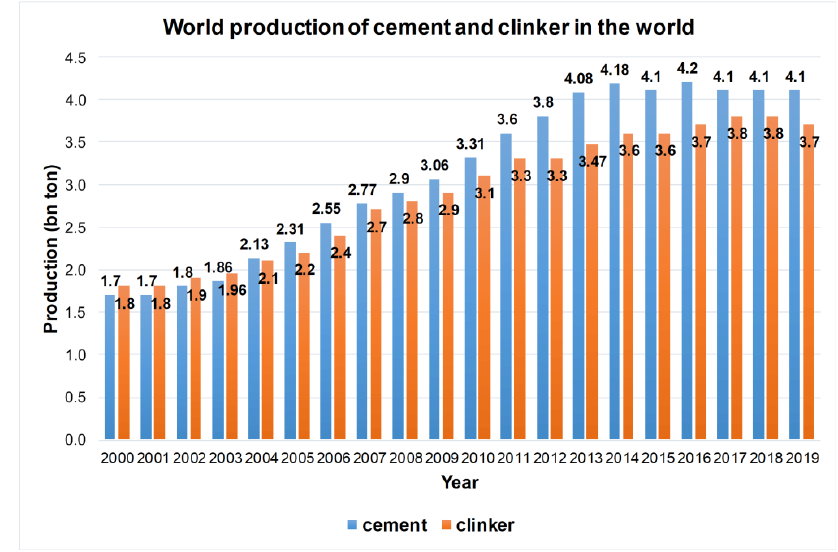
Figure 1. World cement and clinker production at the beginning of the 21st century [5].